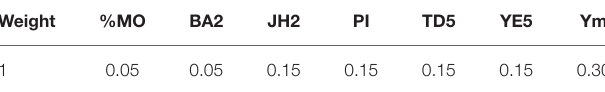
TABLE 5 | Weights for selection index ideotype characterization.